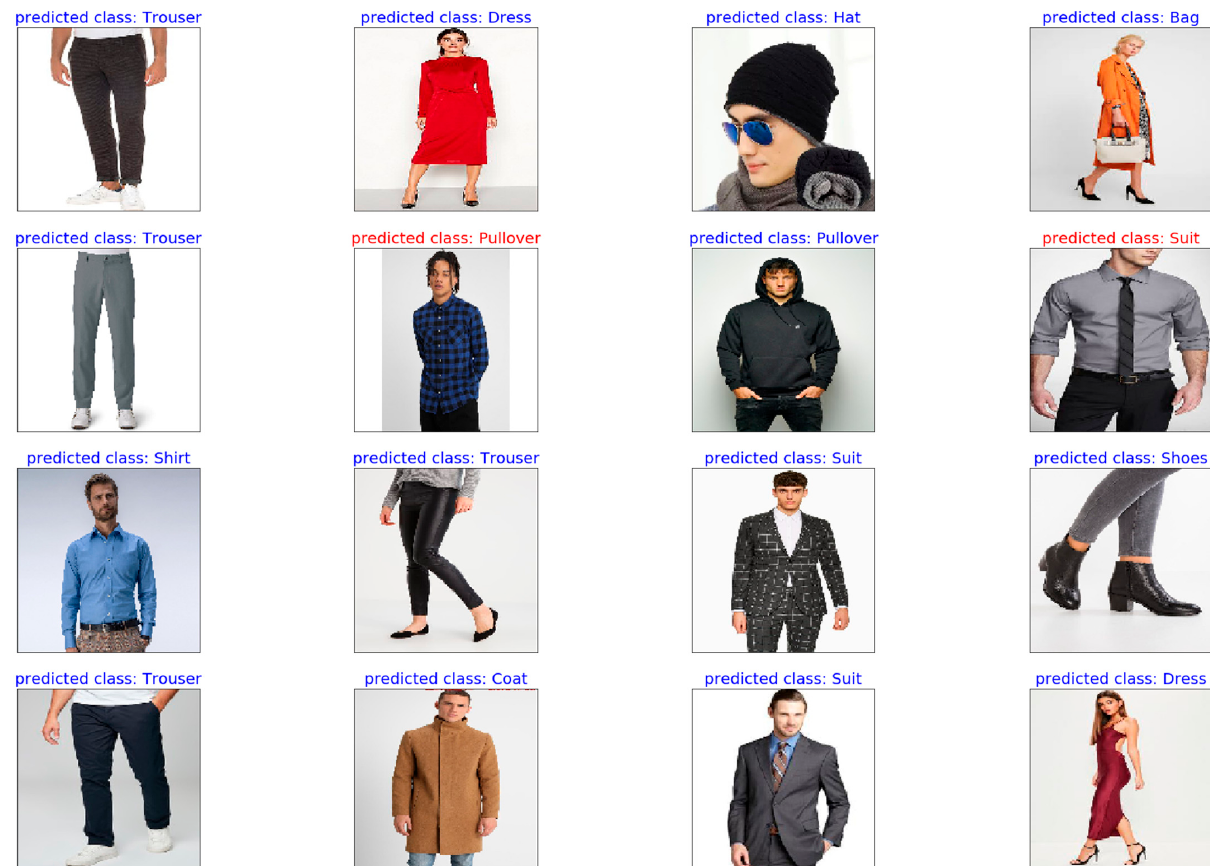
Figure 21. Predicted class labels for 16 randomly selected test images.